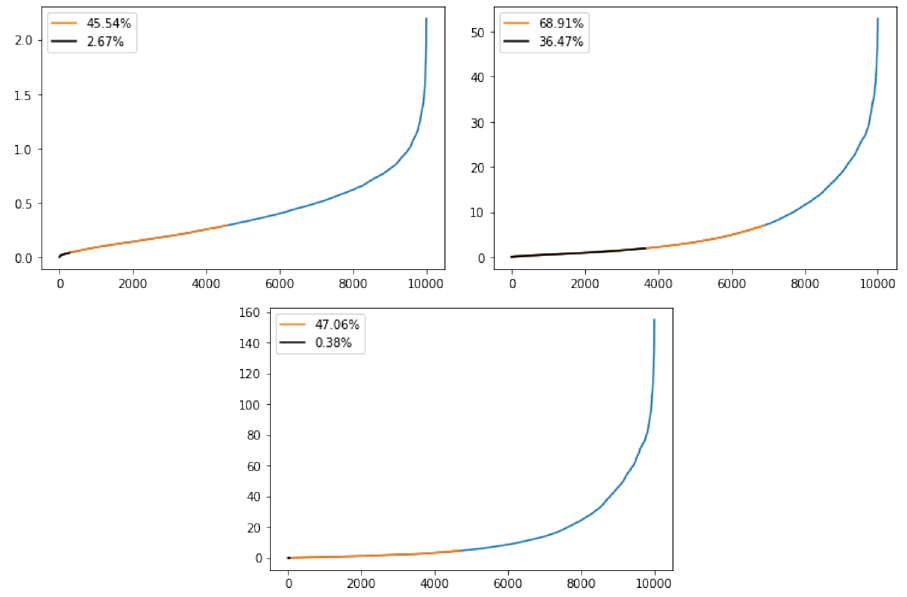
Figure 6 . From top to bottom, left to right, we have plotted the sorted 10,000 random losses for each seven functionals: L